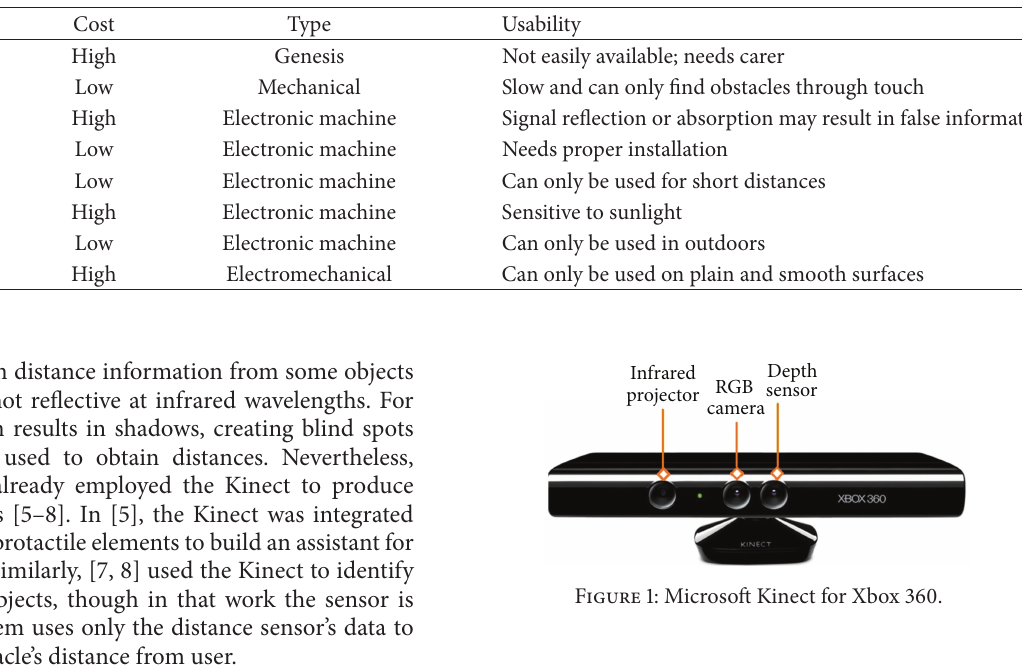
Table 1: Commonly used sensory aids for visually impaired persons.